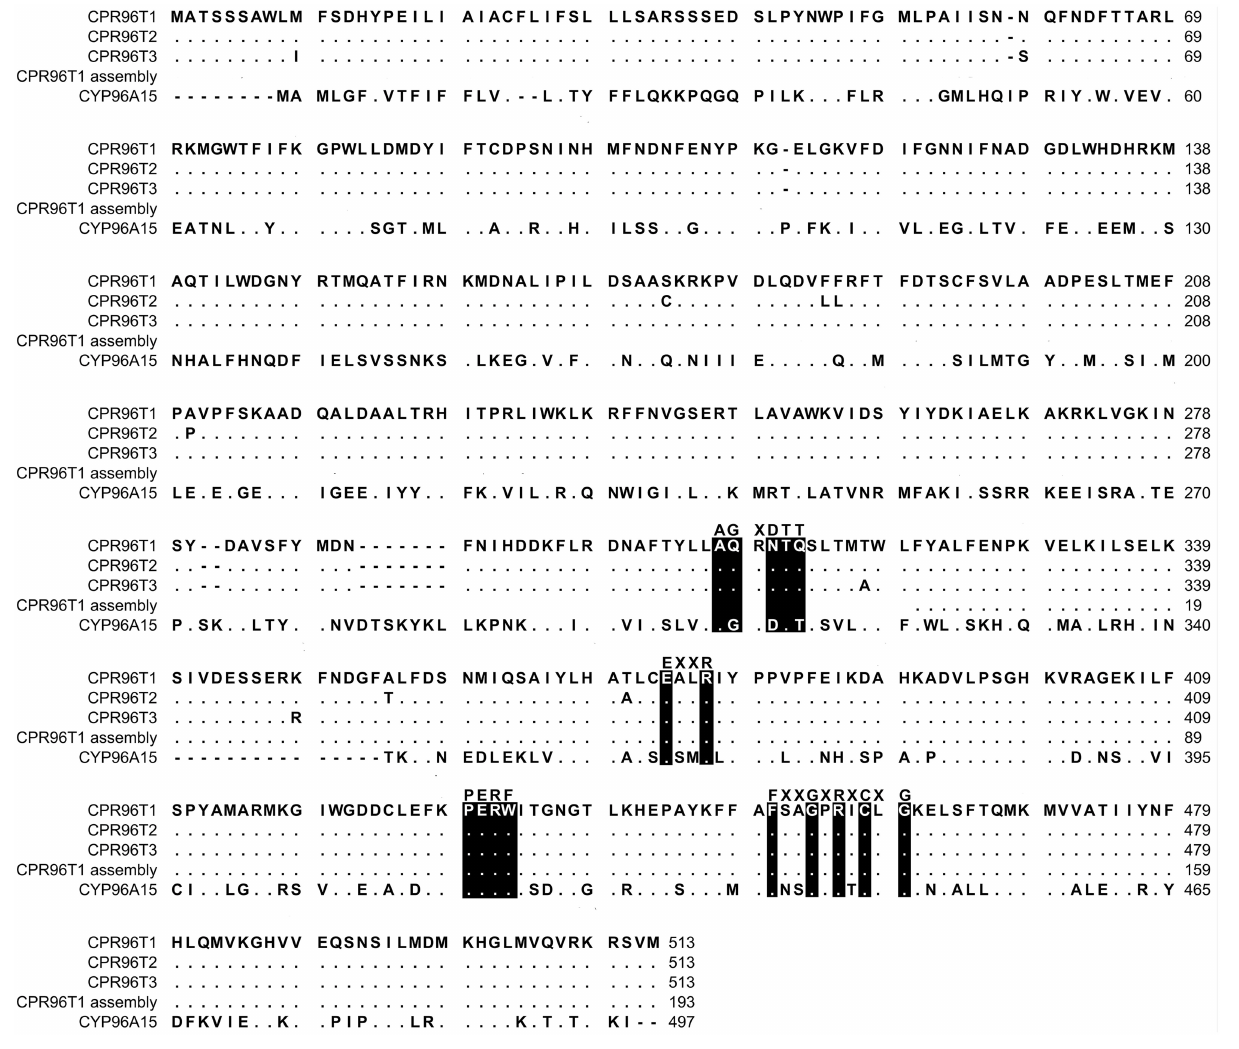
FIGURE 4 | MUSCLE alignment of protein sequences. The sequences include CYP96T1, CYP96T2, CYP96T3, the CYP96T1 from the N. sp. aff. pseudonarcissus ABySS and MIRA assembly, and CYP96A15 from A. thaliana (Q9FVS9). Simplified consensus motifs for cytochrome P450 enzymes are placed above the corresponding color inverted CYP96T1 sequence. Dots are exact matches to CYP96T1 and dashes are